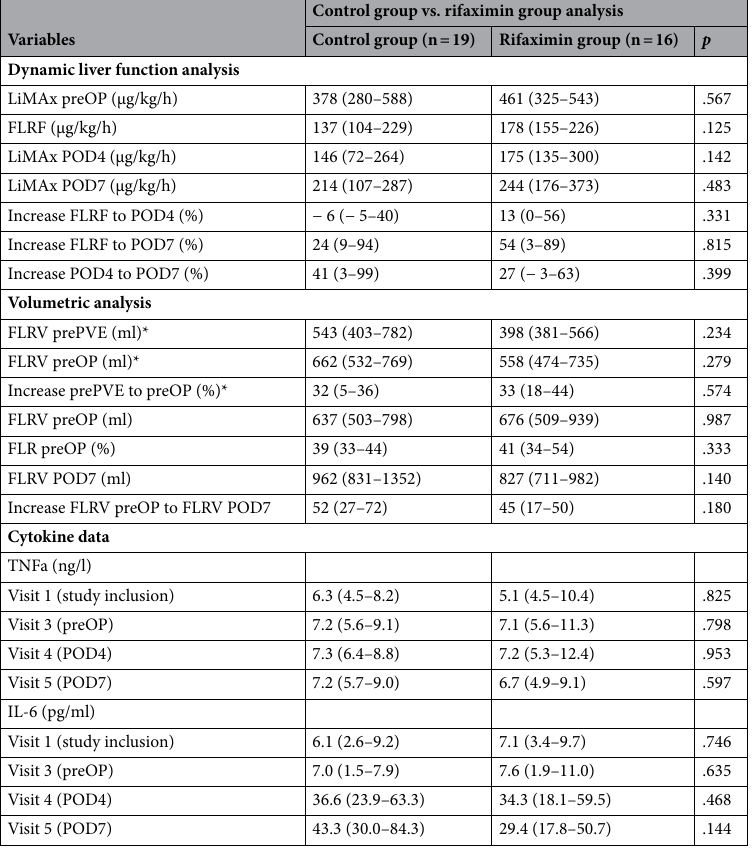
Table 1. Comparative analysis of the trial cohort. Data presented as median and interquartile range if not noted otherwise. Categorical data were compared using the chi-squared test, fisher’s exact test or linear- by-linear association according to scale and number of cases. Data derived from continuous variables of different groups were compared by Mann–Whitney-U-Test. *Data only shown for patients who underwent PVE. AE, adverse event; ALT, alanine aminotransferase; AP, alkaline phosphatase ASA, American society of anesthesiologists classification; AST, aspartate aminotransferase; BMI, body mass index; CRP, c-reactive protein; FFP, fresh frozen plasma; FLR, future liver remant; FLRF, future liver remnant function; FLRV, future liver remant volume; GGT, gamma glutamyltransferase; IL, Interleukin; ISGLS, International Study Group for Liver Surgery; LiMAx, Liver function capacity; POD, postoperative day; preOP, preoperative day 1; PVE, portal vein embolization; SAE, serious adverse event; TNF, tumor necrosis